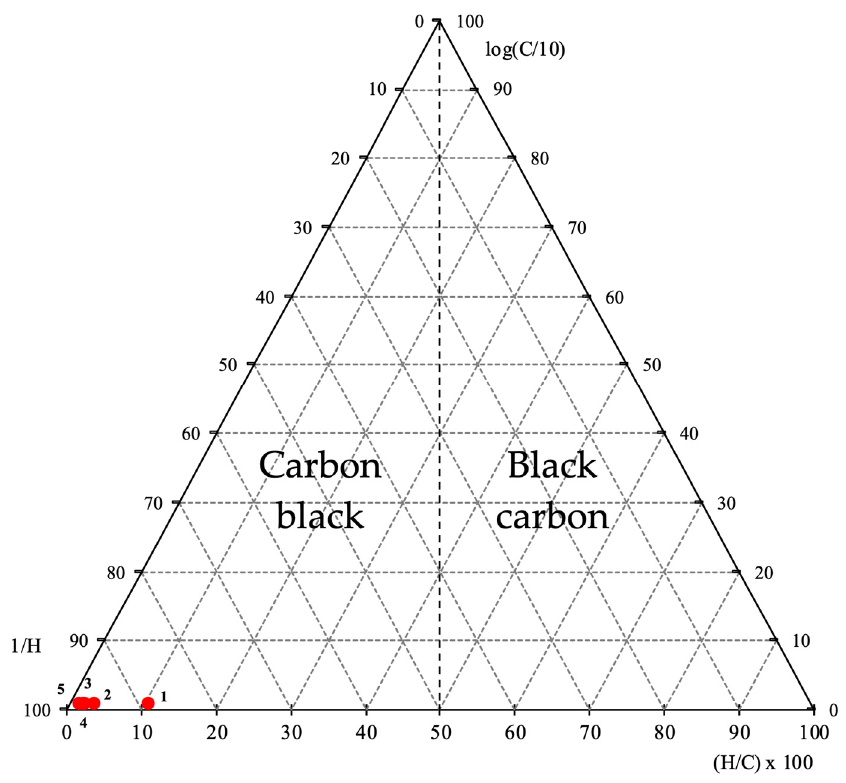
Figure 3. Projection of the results obtained for the ratios H/C × 100—log(C/10)—1/H, calculated with the average value of the elementary composition of the rubber (1), RC 300 °C (2), RC 400 °C (3), RC 500 °C (4) and RC 600 °C (5) samples (diagram adapted from [54] ).